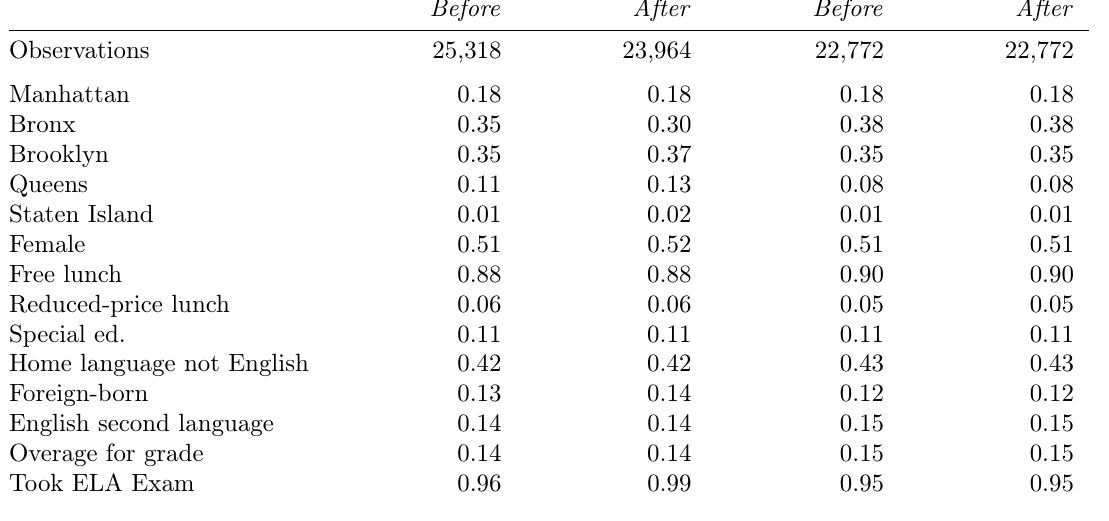
Table 2: Mean Differences in Characteristics of Students Exposed to Violent Crime Before and After Exam Full Sample ELA Math Before After Before